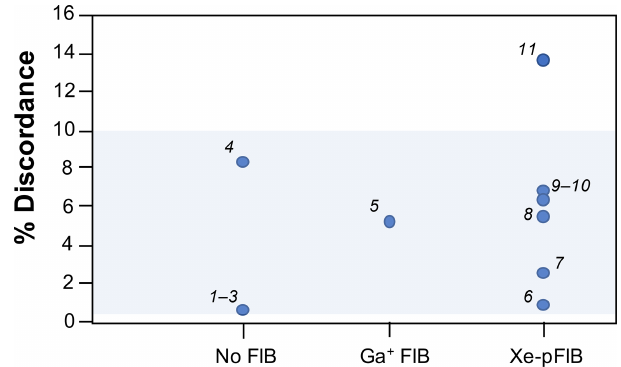
Figure 4. Percentage discordance plotted against extraction method. Discordance reported by Heaman (2009), is shown by the transparent box, and individual data points are numbered in refer- ence to Table